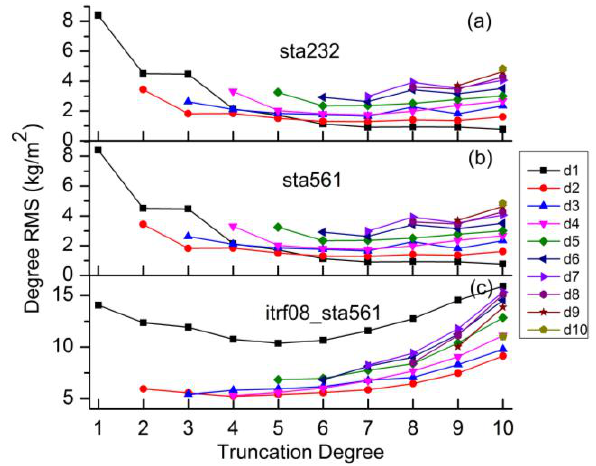
Figure 2. Degree RMS differences between coefficients inverted from GPS displacements and the reference values discussed in Section 2.1. The d1–d10 curves denote the degree RMS differences of degree 1-degree 10 coefficients inverted with different truncation degrees. Three scenarios of GPS displacements are used: The simulated displacements of 232 IGb08 stations ( a ) and 560 ITRF08 stations ( b ), and the real ITRF08-GPS residuals of 560 stations ( c ).